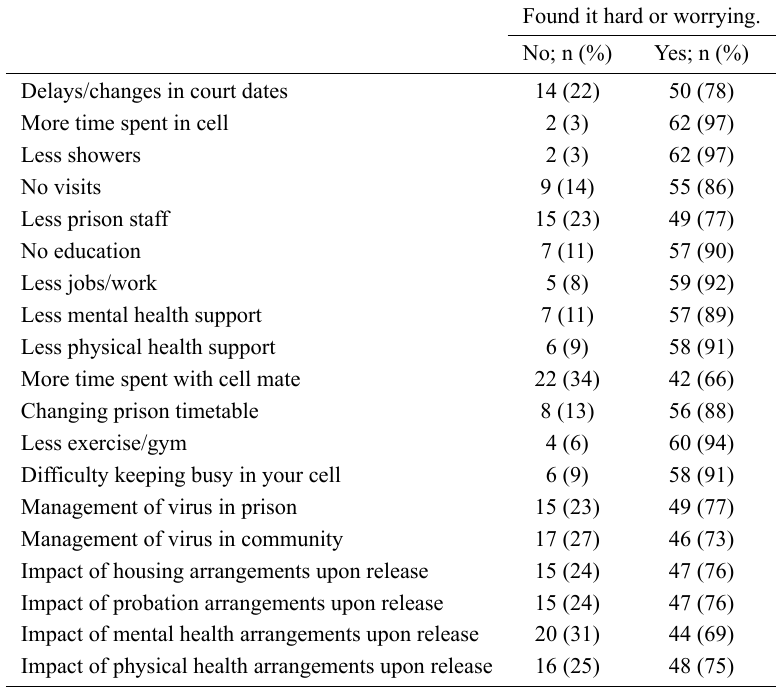
Table 1. Whether prisoners found SARS-CoV-2 related changes and stressors hard or worrying; frequencies and percentages.